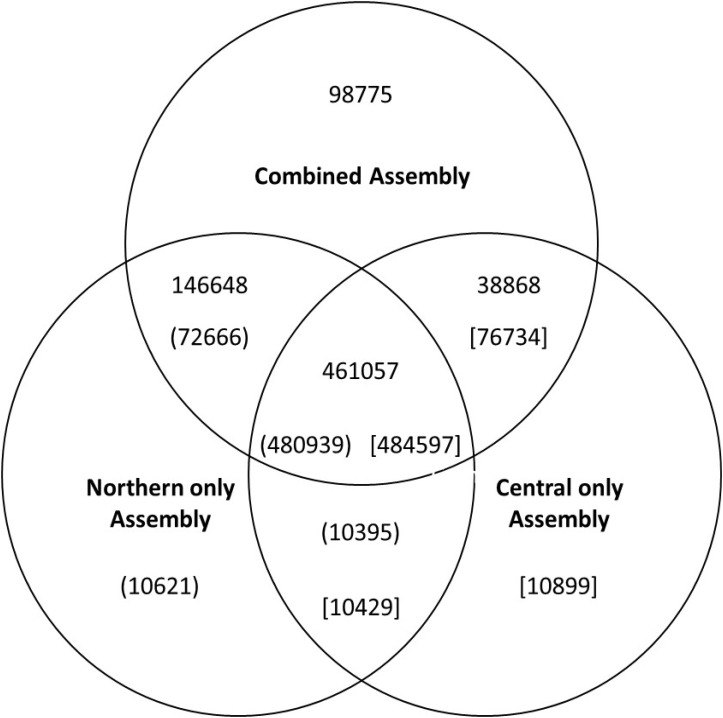
Venn diagram showing the numbers of uniquely assembled contigs in each of the three assemblies and the number of contigs which were assembled in more than one assembly process. The numbers in parenthesis or brackets indicate the number of commonly assembled contigs identified from reverse BlastN analysis. The differences in numbers for each comparison is because some individual contigs had best matches multiple contigs in the various analyses.